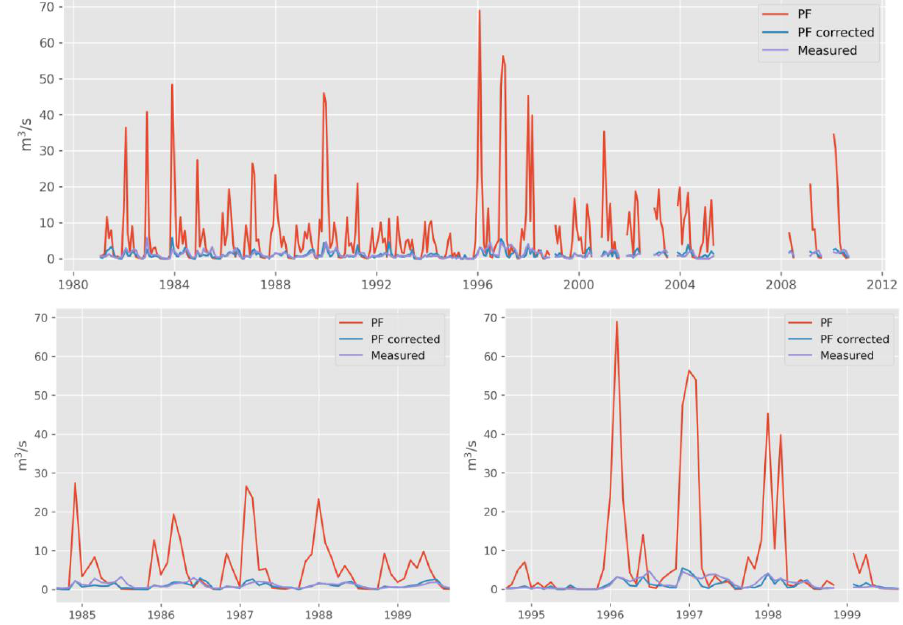
Figure 5. Comparison between monthly average river flow of the reference simulation of European Hydrological Predictions for the Environment (E-HYPE) (perfect run PR) and the measured data for the overlapping period of 1981–2010, before and after the application of downscaling and correction methodology to seasonal forecast data. In the lower plots, the details for a series of dry years ( left ) and wet years ( right ).